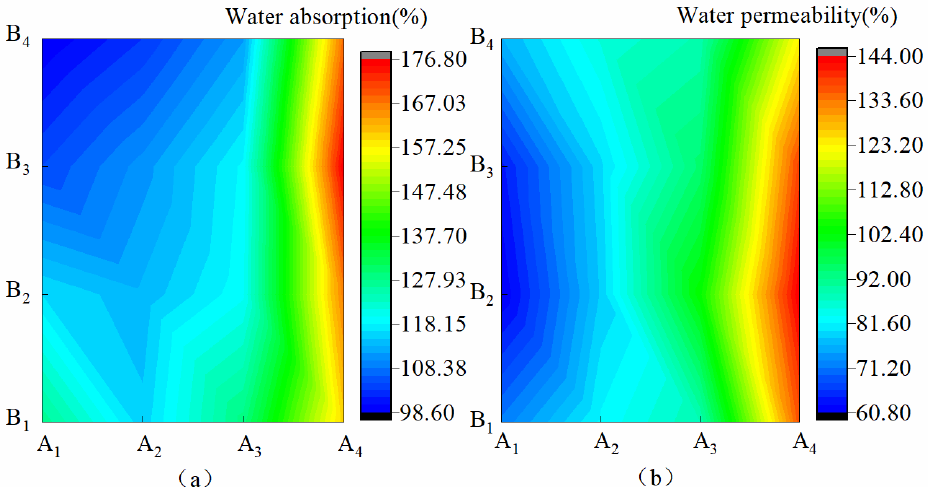
Figure 1. Hydrophilicity of membrane materials under different ratios of water-based copolymer and zeolite amounts. ( a ) Water absorption, ( b ) Water permeability